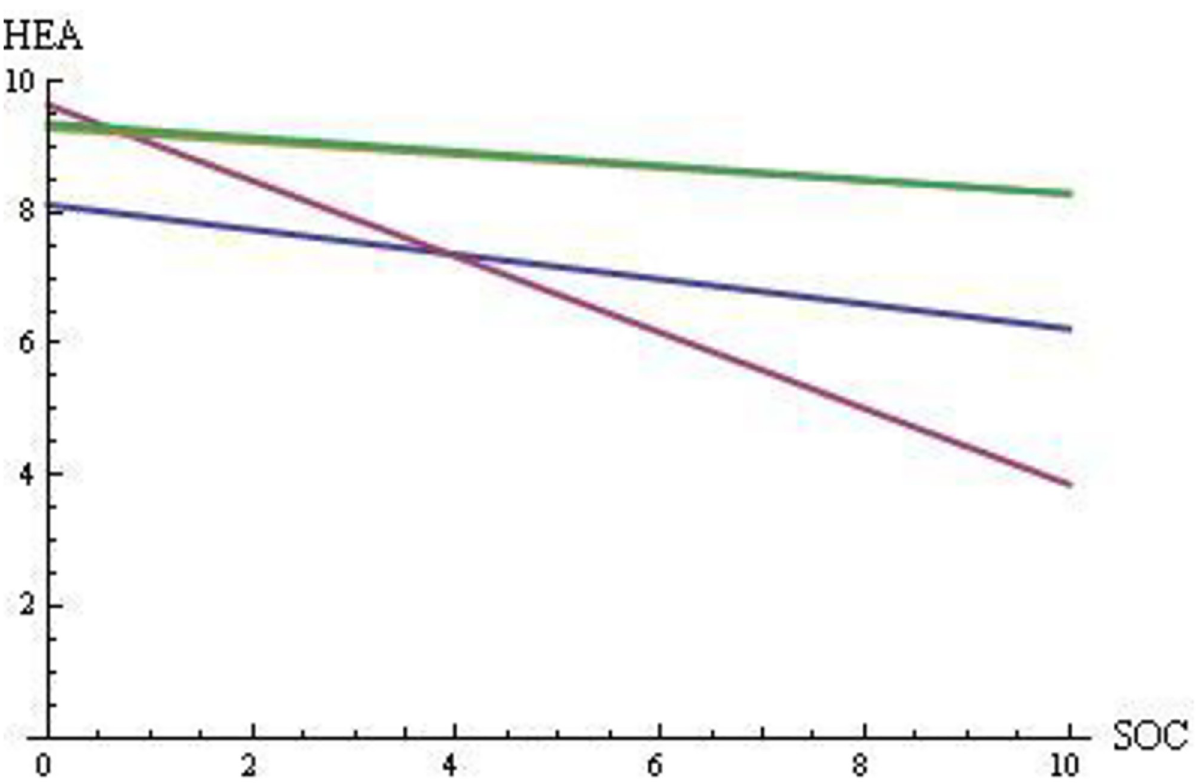
Fig 2. Social benefits (SOC) in [0, 10] vs. health (HEA) in [0, 10] if the relative contributions to happiness have values of α = 0.125, β = 0.75, and γ = 0.125. For composers (blue) CO: HEA = -0.189 SOC + 8.115; for painters (purple) PA: HEA = -0.578 SOC + 9.633; for mathematicians and physicists (yellow) MP: HEA = -0.099 SOC + 9.2763; and for biologists and chemists (green) BC: HEA = -0.107 SOC + 9.355.